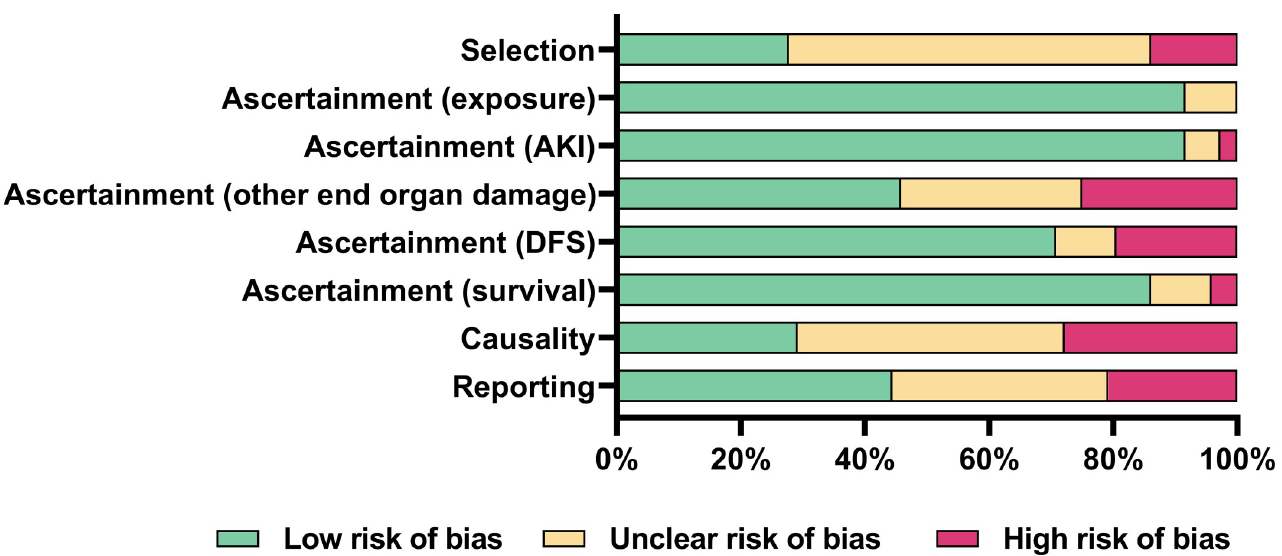
Fig 2. Risk of bias of included studies. Reviewer judgements about each risk of bias item presented as percentages across all included studies using the Murad et al risk of bias tool [33]. AKI: acute kidney injury; DFS: dialysis free survival.